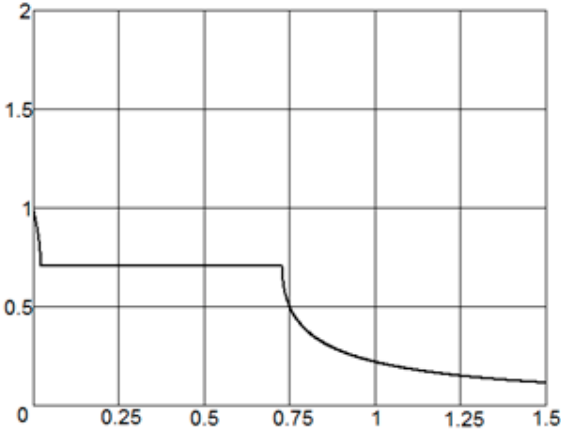
( ) , x ψ π graph. Figure 1. The function ψ ( x , π )